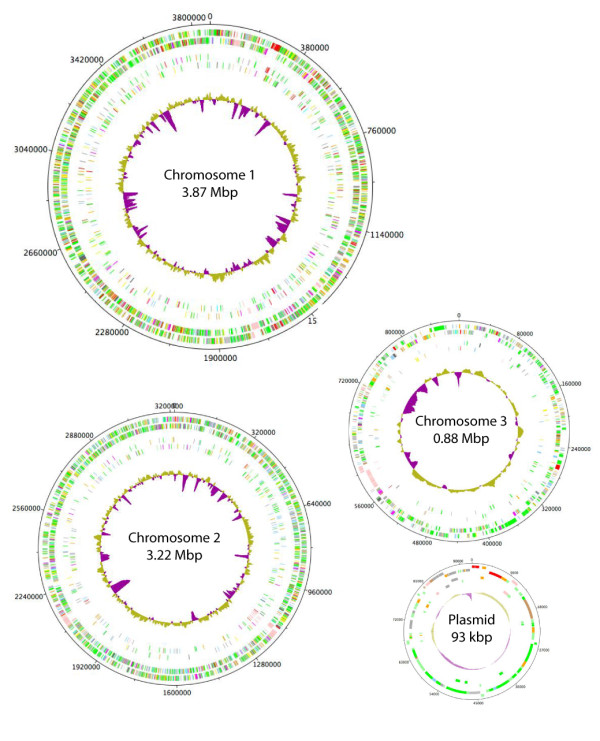
Distribution of genes differentially expressed by intracellular B. cenocepacia among the four genomic replicons. The outer pair of concentric circles represents both coding strands of the B. cenocepacia genome. The second pair of concentric circles represents genes with increased (outer) and decreased (inner) expression by intracellular B. cenocepacia. Percentage of G+C is also shown, with above average in yellow and below average in purple. Chromosome 3 is 3x scale; the plasmid is 17.5x scale.